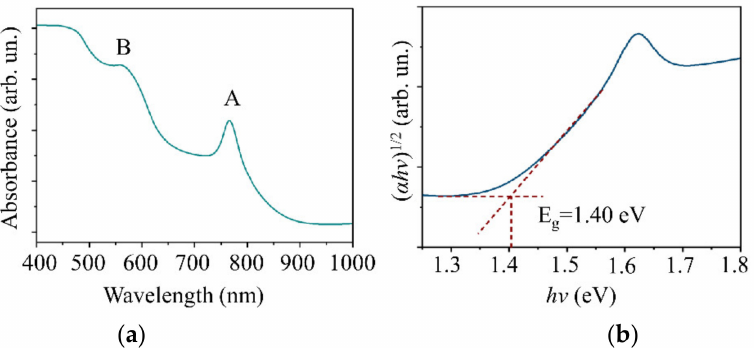
Figure 7. ( a ) Optical absorption spectra and ( b ) Tauc plots for the WSe 2 film on the sapphire substrate. The A and B peaks are explained by excitonic